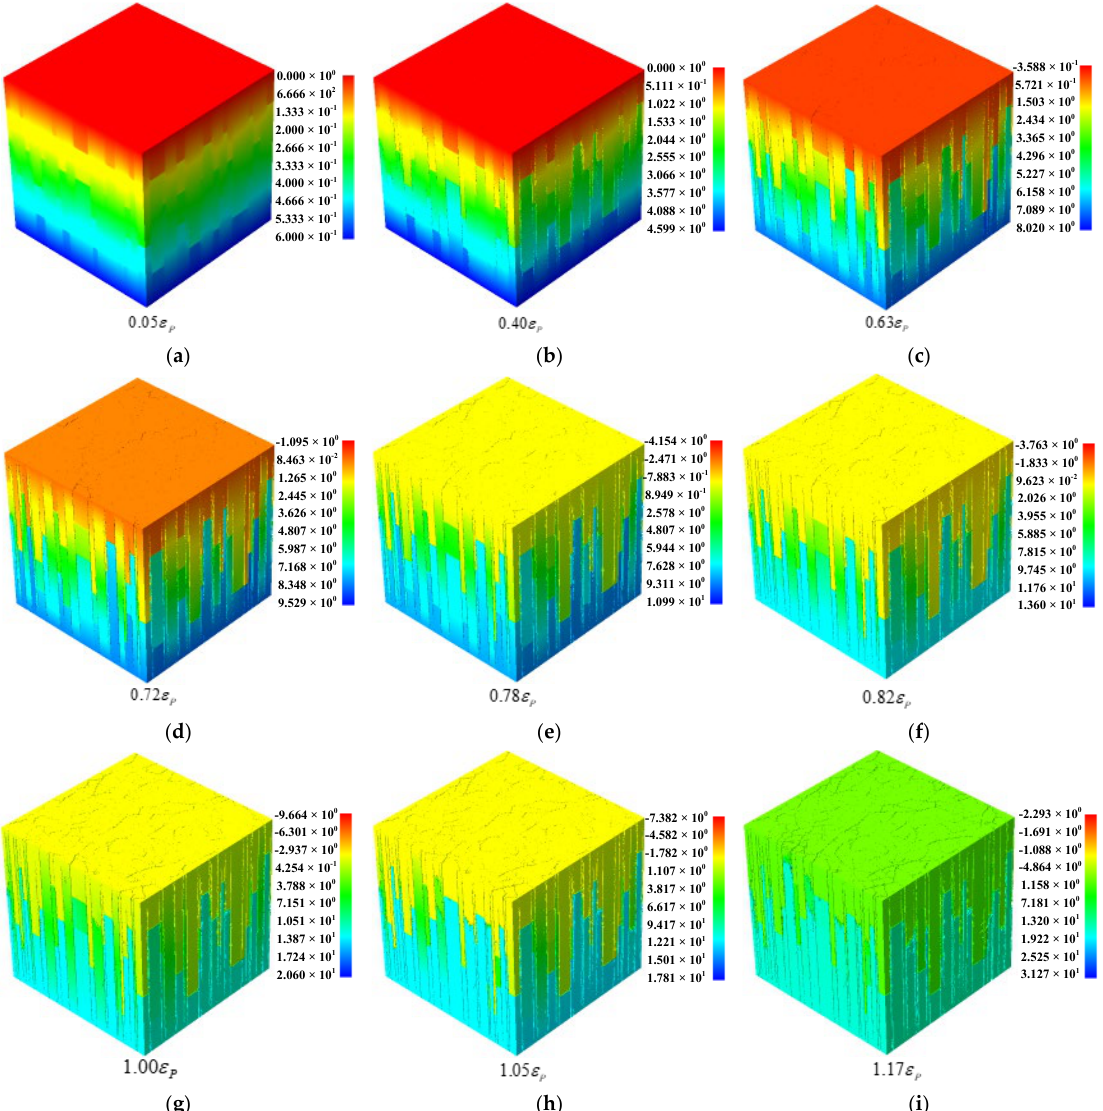
Figure 14. Numerical uniaxial compression test of columnar jointed basalt at the macroscale. ( a – i ) Vertical displacement contours at different loading stages, ( a – i ) correspond to points A–F in Fig-